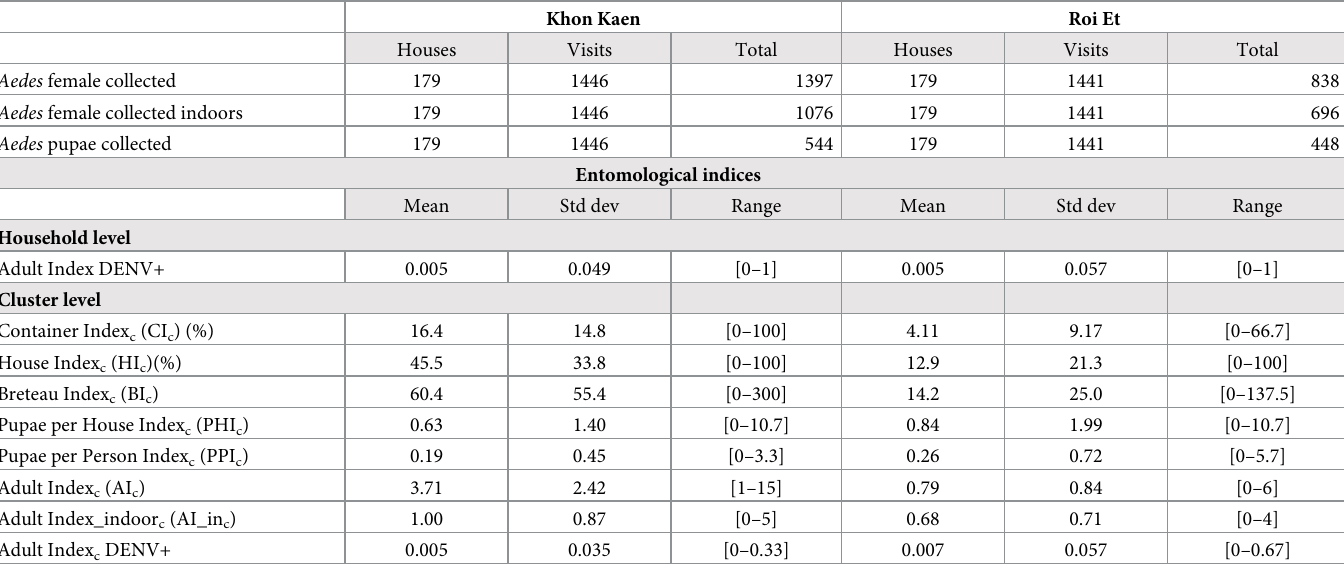
Table 3. Entomological collection data and indices at household and cluster